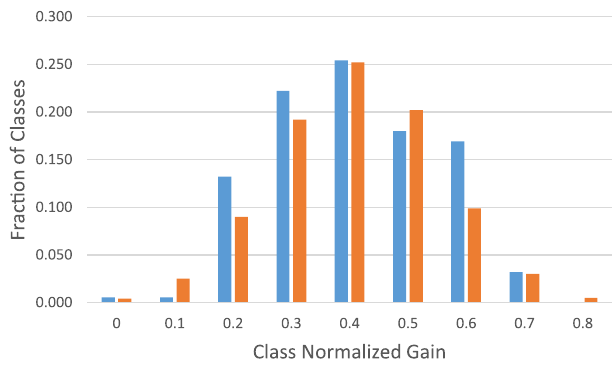
FIG. 3. Comparison of the distribution of class normalized gains for 189 IE classes reported by Von Korff (blue) with a normal distribution (red) having the same median (0.40) and standard deviation